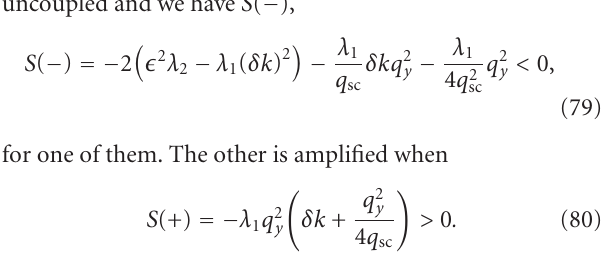
Figure 4: Numerically computed secondary instability regions of Eckhaus instability (E), Zigzag instability (Z), and stable regions (S) are plotted in ( λ 2 /λ 1 , δq s )-plane for Q = 2000, D a = 1500, Λ = 0 . 85, φ = 0 . 9, M = 0 . 9, Pr 1 = 1, and Pr 2 = 2. As | δq s | increases then the secondary instability regions